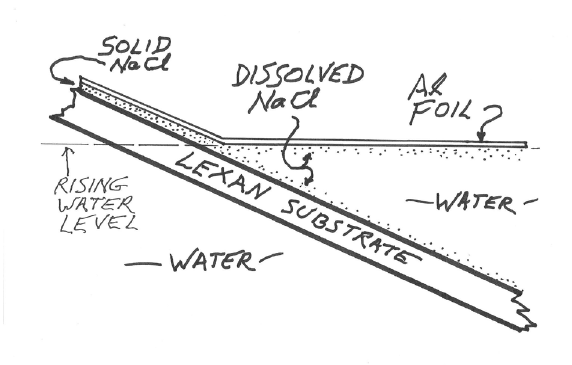
Fig. 3 : Detail of parting agent during floating.